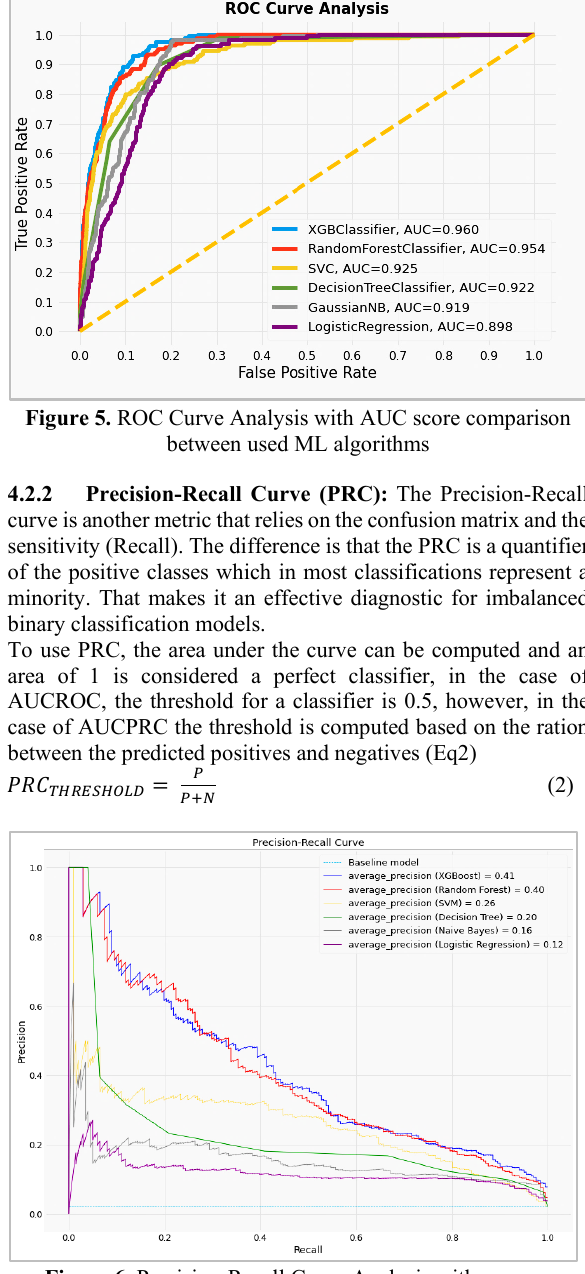
Figure 6. Precision-Recall Curve Analysis with average precision score comparison between used ML